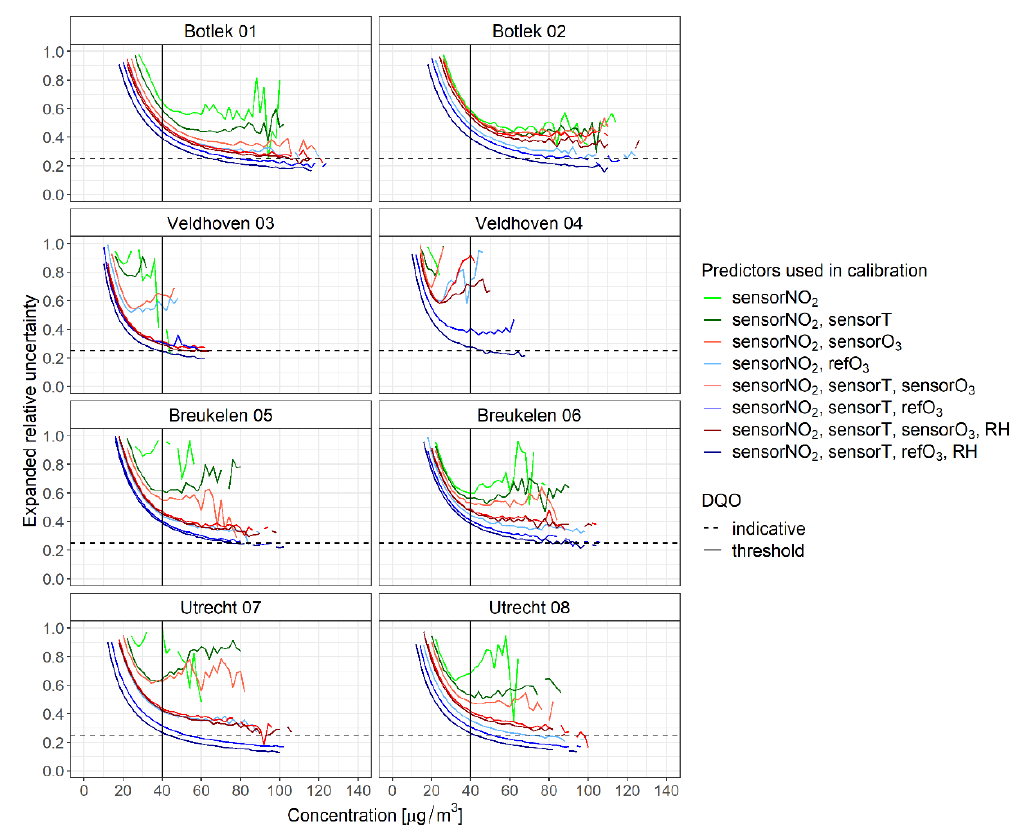
Figure 6. Relative expanded uncertainty of the predicted values versus reference data as a function of the level of NO 2 for the calibration models. Green, red and blue lines, respectively indicate calibrations without ozone, calibrations with sensor ozone and calibrations with reference ozone. The dashed line shows the DQO for indicative measurements.